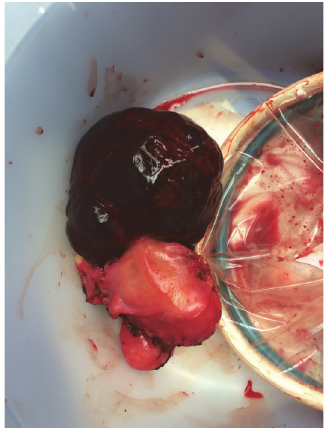
Figure 1: Computed tomography of the abdomen and pelvis showing the 8.8 × 7.3 × 8.3 cm degenerated fibroid (arrow) and free fluid in Morison’s pouch (arrowhead).